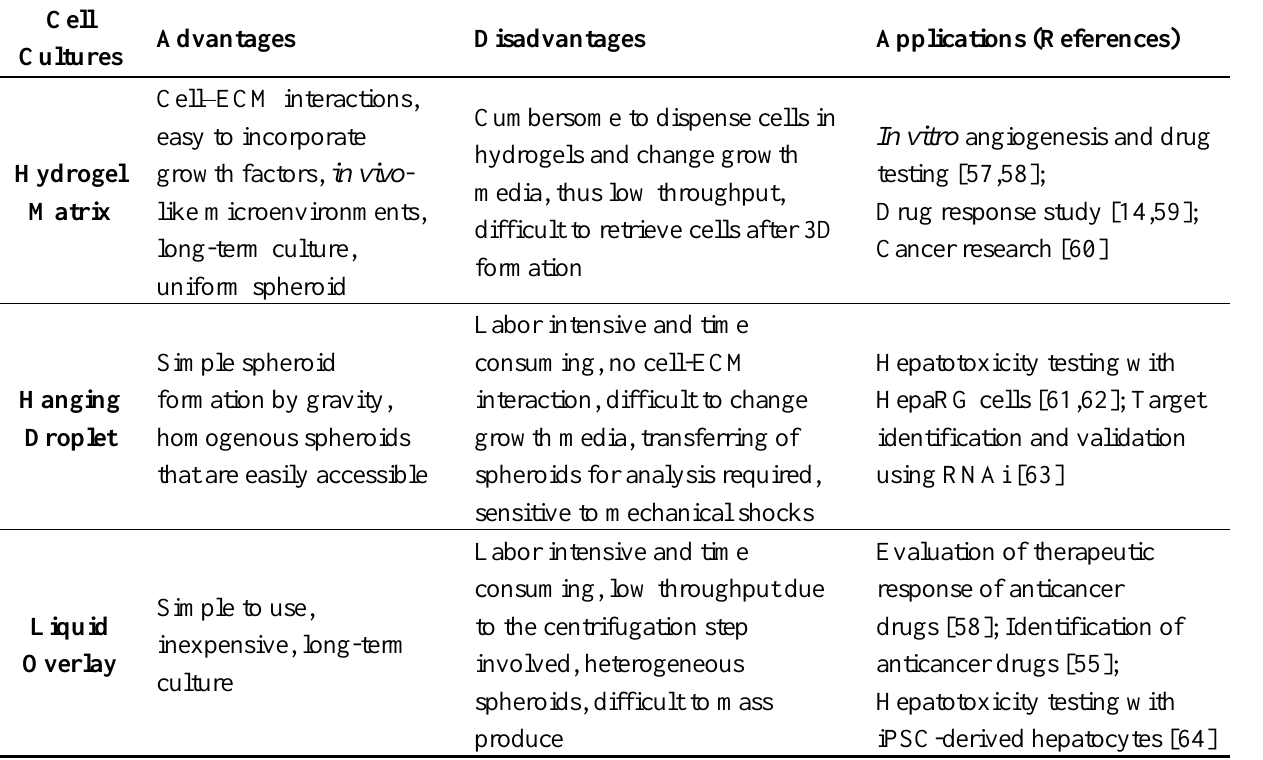
Table 3. Advantages and disadvantages of commonly used 3D cell culture